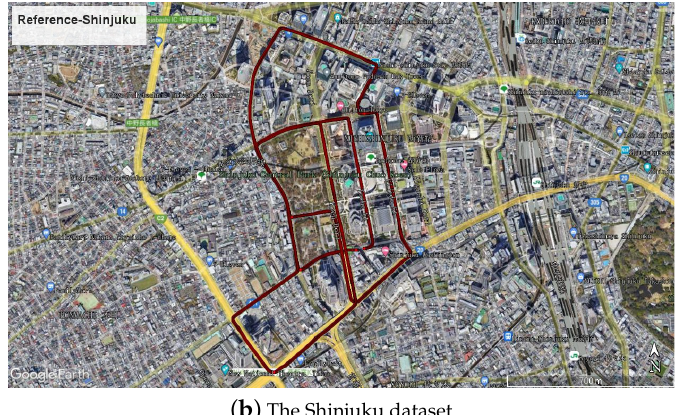
Figure 4. The reference trajectories of the datasets.